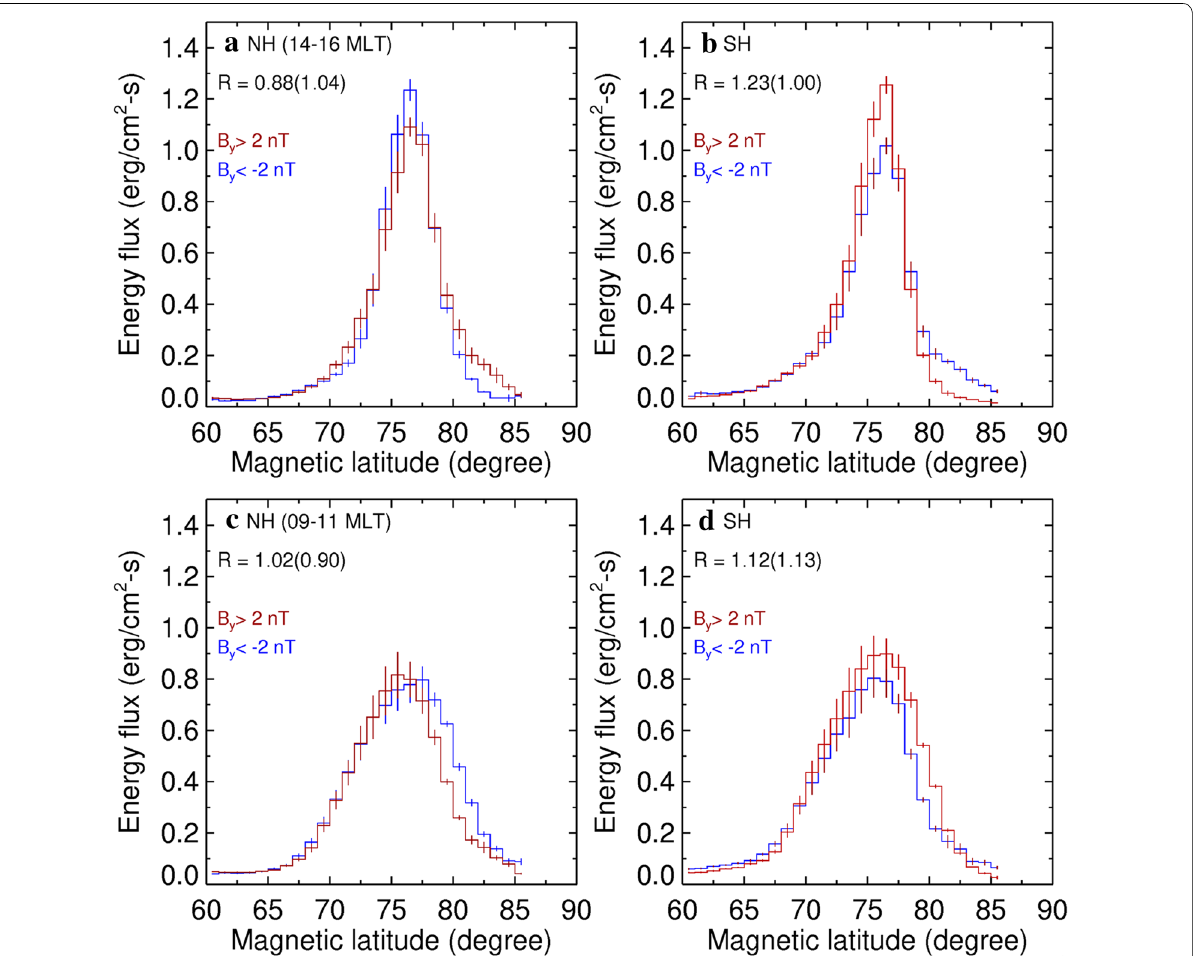
Fig. 5 Latitudinal profiles of auroral energy flux averaged over the 1400–1600 MLT sector for the a Northern and b Southern Hemispheres. In each panel the red trace is for IMF B y > 2 nT and the blue trace is for IMF B y < 2 nT. The vertical line segments are one standard deviation of the sample − means. c , d Are in the same format as ( a , b ) but for the prenoon 0900–1100 MLT sector. The insert values R is the red-to-blue energy flux ratio at the flux peak and, in the parenthesis, integrated over the